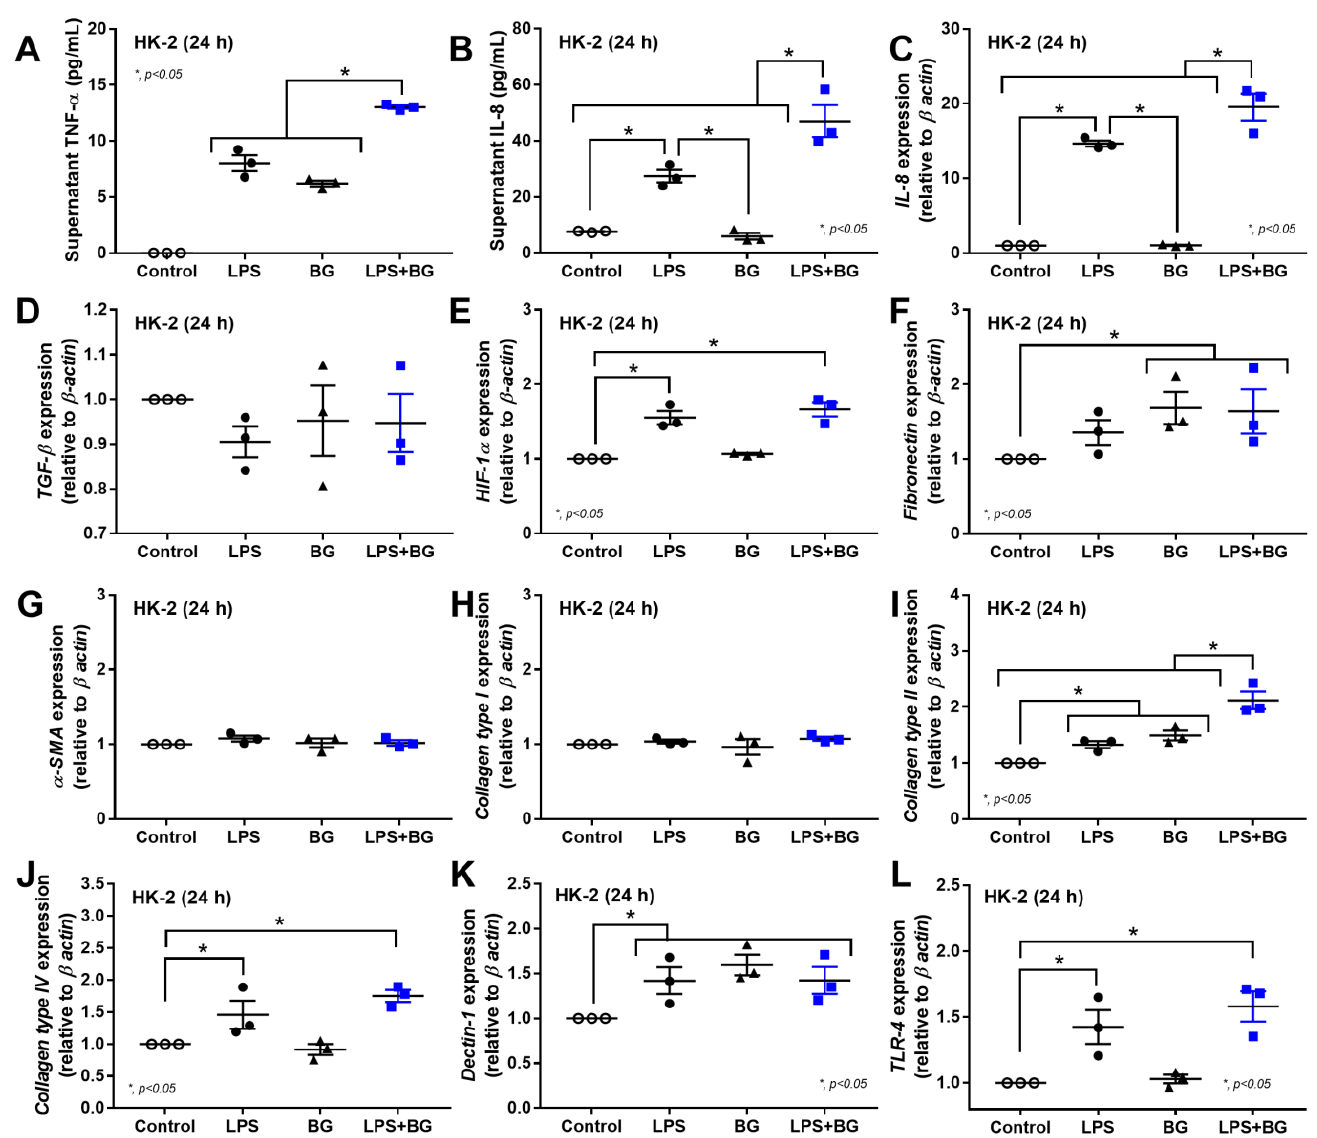
Figure 6. The characteristics of renal tubular cells (HK-2 cells) after 24 h incubation in the culture medium (Control) or lipopolysaccharide (LPS) with or without (1 → 3)-B-D-glucan (BG), as indicated by supernatant cytokines (TNF- α and IL-8) ( A , B ), and the gene expression of cytokines (TGF- β and IL-8) ( C , D ), hypoxia-inducible factor-1 α (HIF-1 α ) ( E ), fibrosis-associated genes, including fibronectin, alpha-smooth muscle actin ( α -SMA), collagen (type I, III, and IV) ( F – J ), and inflammatory mediators (Dectin-1 and Toll-like-receptor 4; TLR-4) ( K , L ) are demonstrated. Independent triplicate experiments were performed for all in vitro experiments.